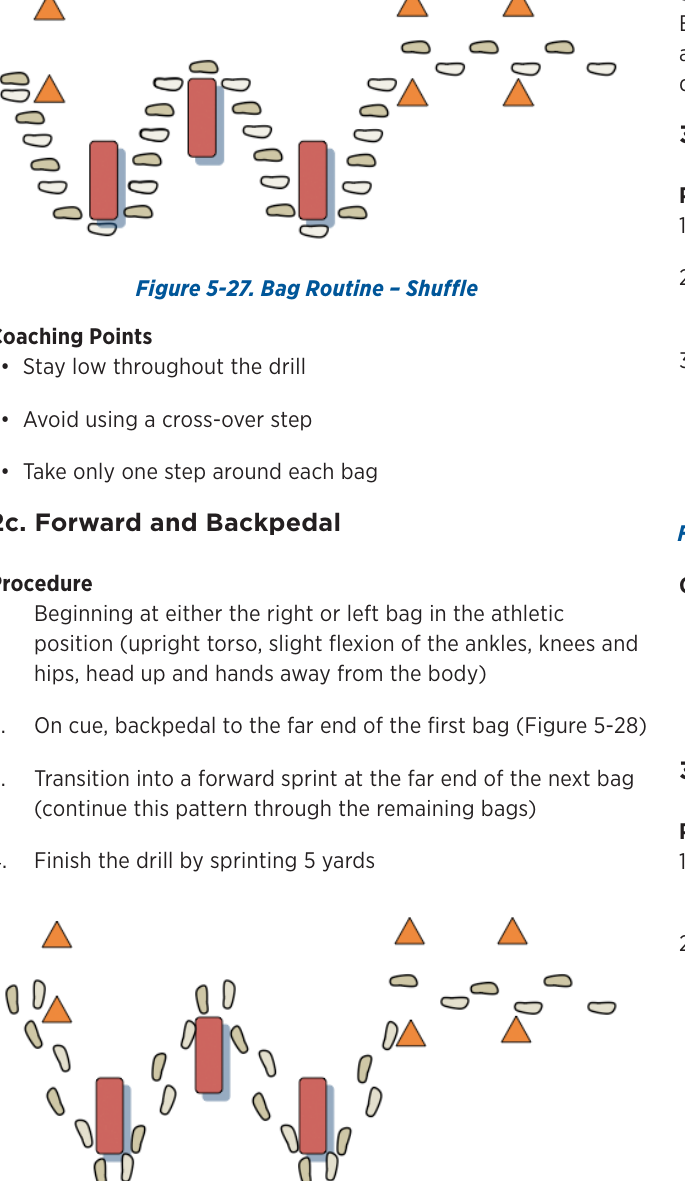
Figure 5-30. Line Jump Routine – Double Bunny